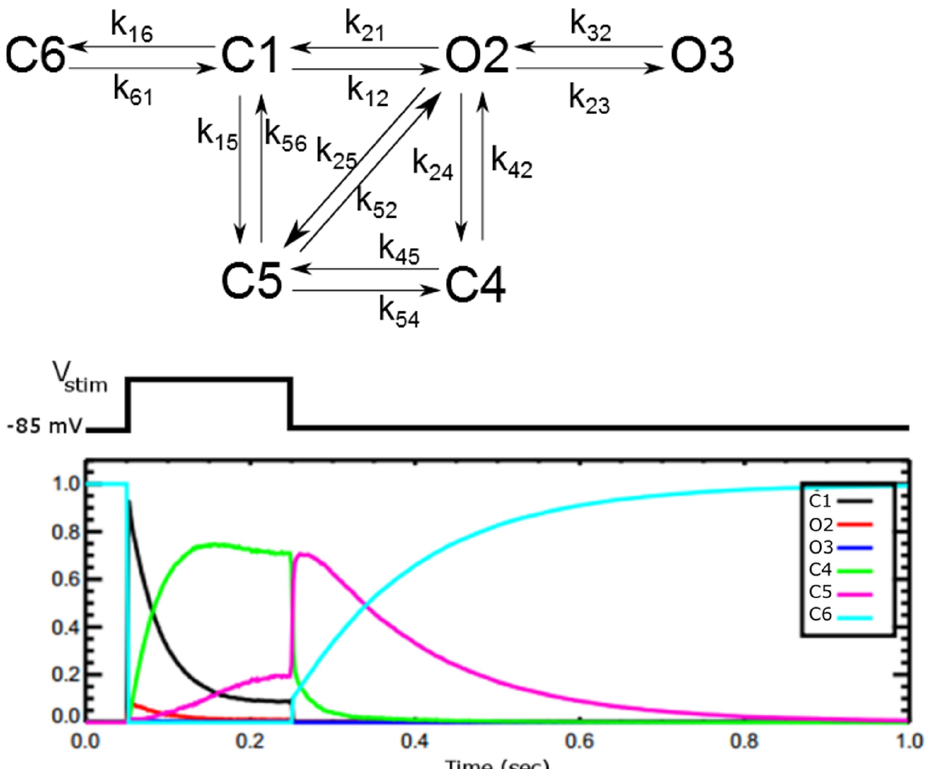
Figure 2. Schematic diagram of the model (top) for the L-type calcium channel (DHPR channel) from [29]. C1 and C6 are closed states with C6 the resting state. O2 and O3 are the open states that conduct Ca 2+ ions with equal conductance. C4 is Ca 2+ -dependent inactivated state. C5 is the voltage-dependent inactivated state. The fraction of LCC channels in different states during the voltage-clamp of V stim = +10 mV for 200 ms (bottom).